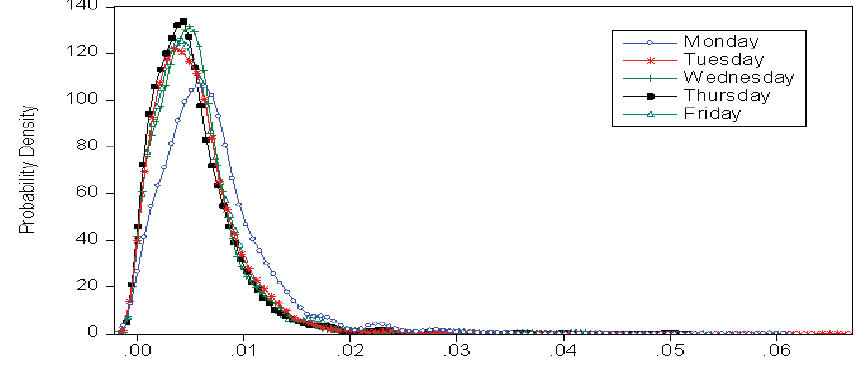
Fig. 8. Probability distributions of gold volatility from Monday to Friday in London